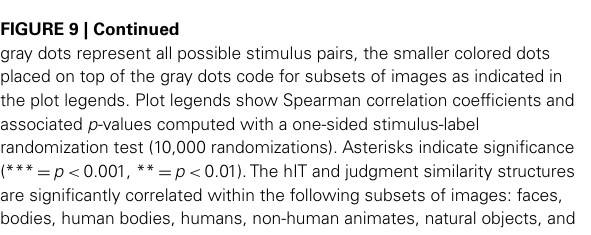
FIGURE 9 | Continued gray dots represent all possible stimulus pairs, the smaller colored dots placed on top of the gray dots code for subsets of images as indicated in the plot legends. Plot legends show Spearman correlation coefficients and associated p -values computed with a one-sided stimulus-label randomization test (10,000 randomizations). Asterisks indicate significance (*** = p < 0.001, ** = p < 0.01).The hIT and judgment similarity structures are significantly correlated within the following subsets of images: faces, bodies, human bodies, humans, non-human animates, natural objects, and